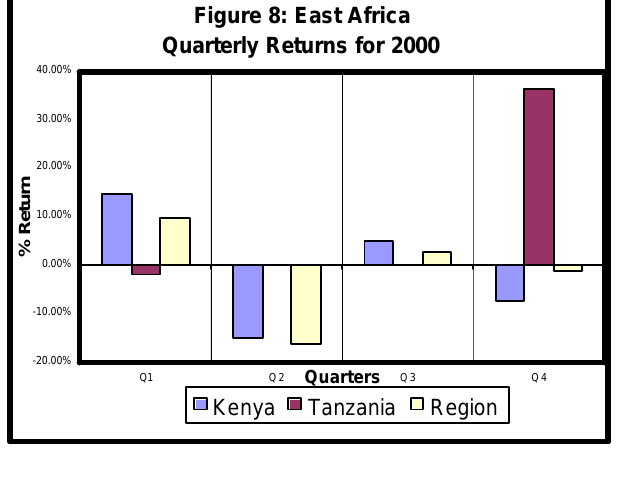
Figure 9: East Africa